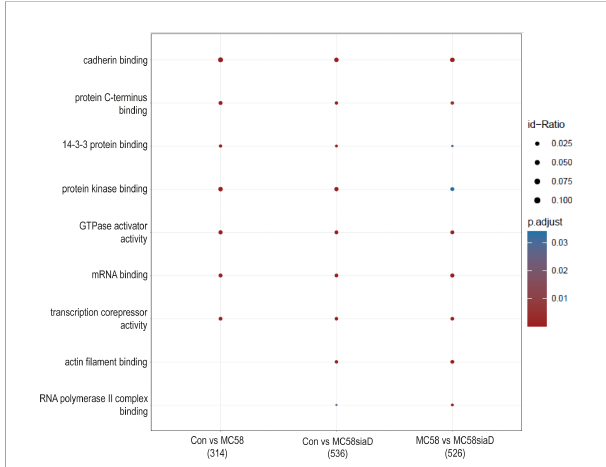
FIGURE 4 Enrichment analysis of molecular functions after infection with